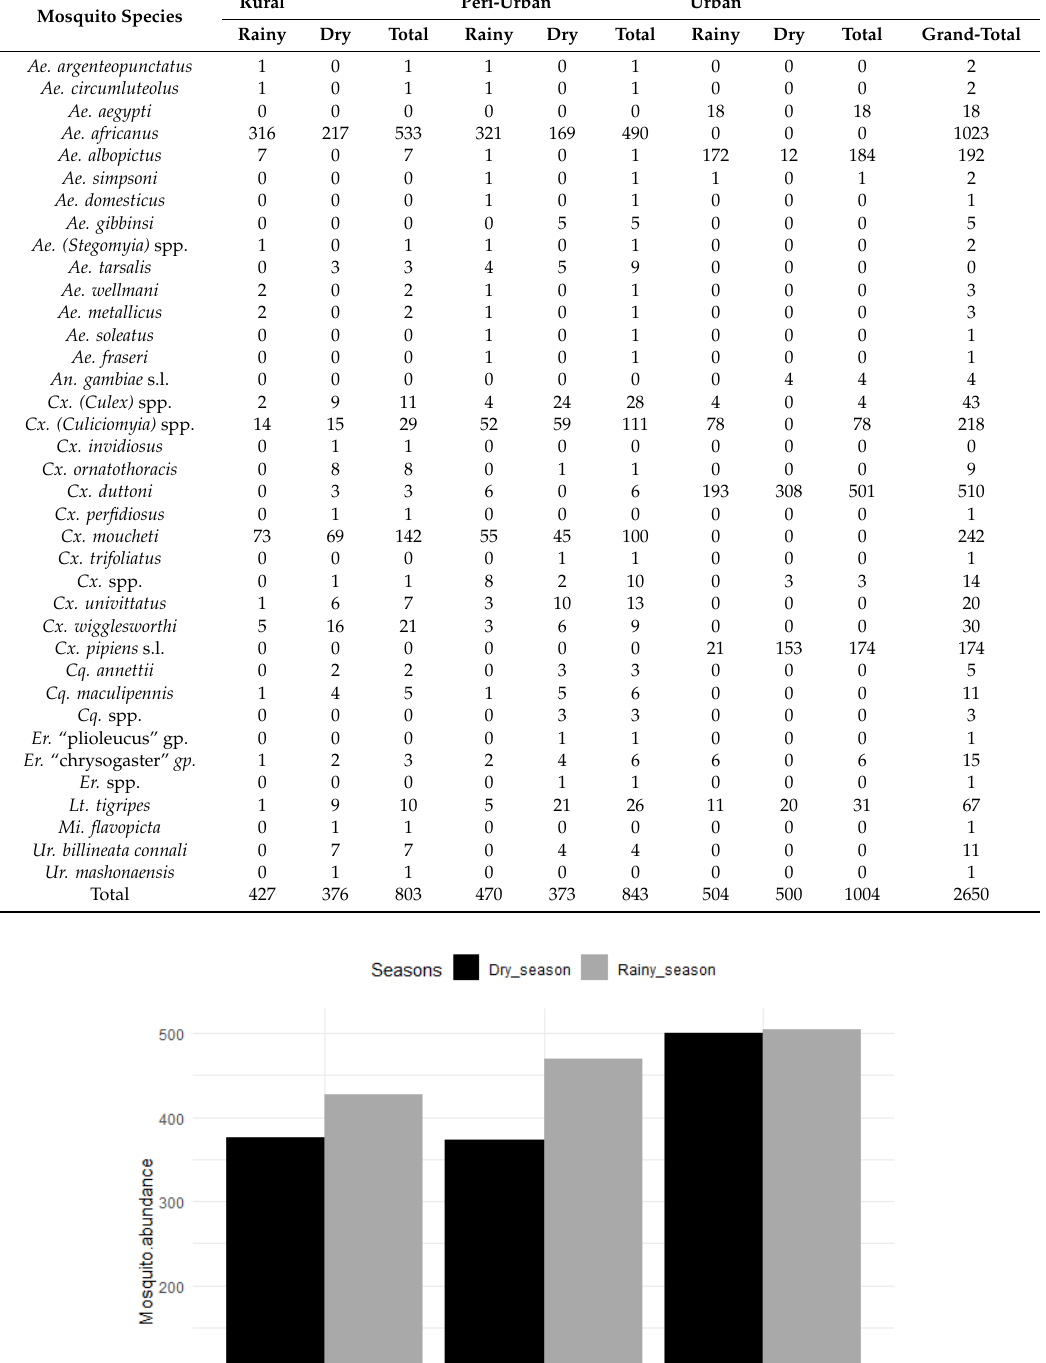
Table 1. Total number of mosquito species collected from each habitat type (rural, peri-urban and urban) and seasons (rainy and dry) combination in Dschang, West-Cameroon. Mosquito Species